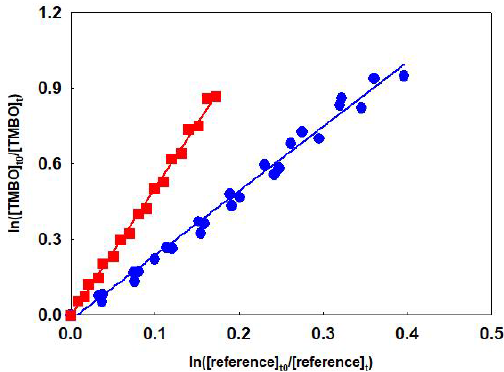
Figure 1. Relative-rate data for the reaction of OH radicals with ( E )-4-methoxy-3-buten-2-one using propene ( ) and isobutene ( ) as reference compounds at 298K and the atmospheric pressure of air.